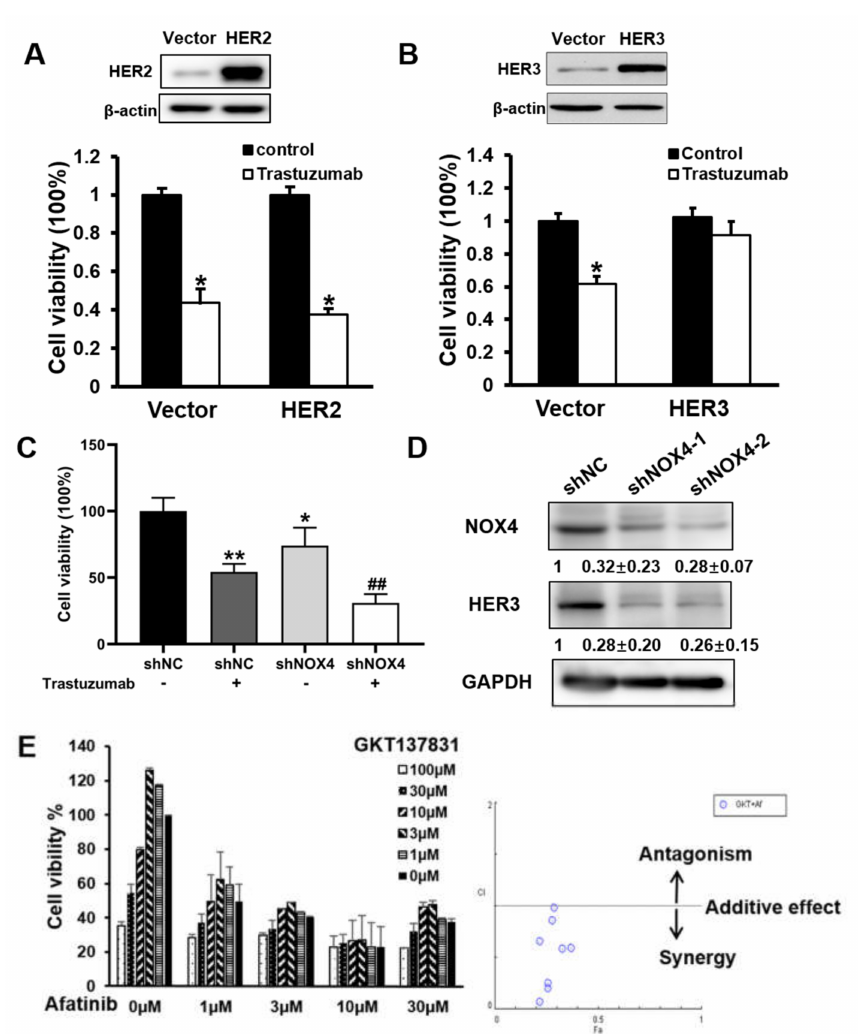
Figure 4. NOX4 knockdown increased the sensitivity to trastuzumab treatment via downregulating HER3 in ovarian cancer cells. ( A , B ) Overexpression HER2 and HER3 in A2780 cells; cells were treated with Trastuzumab and cell viability was detected via CCK8. ( C ) Knockdown of NOX4 in the cells via shNOX4; cells were treated with trastuzumab (100 mg/mL) for 4 days, and cell viabilities were detected by CCK8. * indicates significant difference at p < 0.05 compared with trastuzumab alone or shNOX4 group, ** indicates significant difference at p < 0.01 compared with trastuzumab alone or shNOX4 group, # indicates significant difference at p < 0.05, ## iindicates significant difference at p < 0.01. ( D ) The expression levels of HER3 in NOX4 knockdown cells were de-tected via Western blotting. ( E ) Combination treatment of NOX4 inhibitor (GKT137831) and afatinib; cell viability was detected after 72 h and CI values were calculated by software